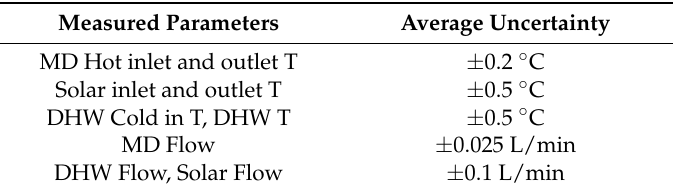
Table 3. Uncertainty of individual parameters .